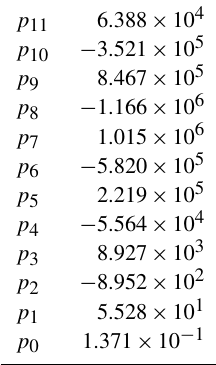
Table A1. Coefficients for the polynomial fit of the dimensionless melt curve ˆ M( ˆ X)